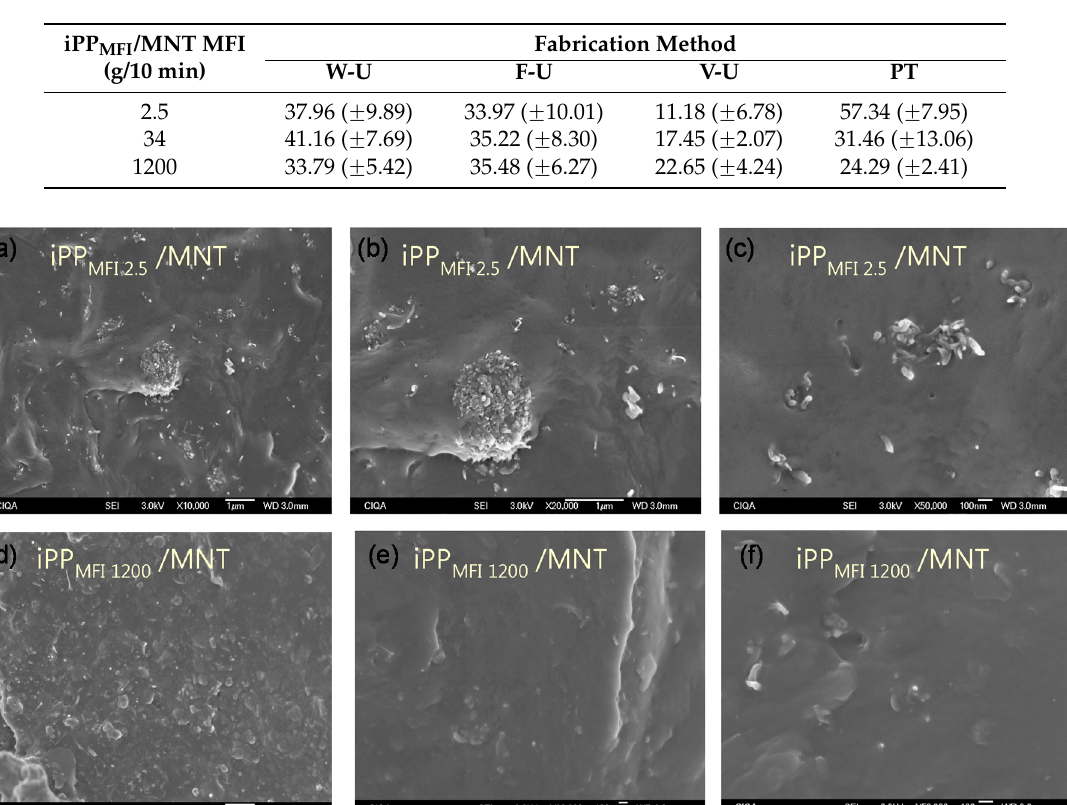
Table 3. Area ratio for iPP/MNT nanocomposites fabricated by different methods.